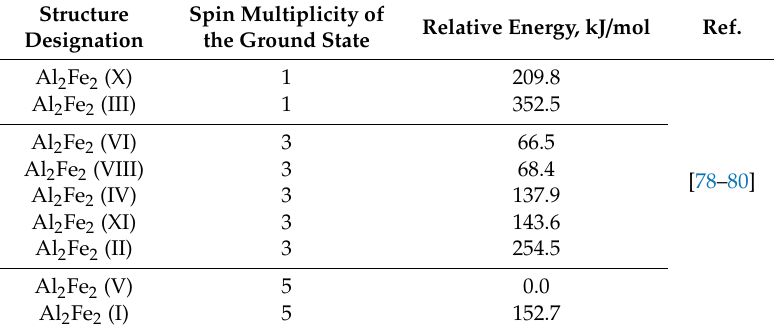
Table 2. Key structural parameters of most stable Al 3 Fe, Al 2 Fe 2 and AlFe 3 metal clusters * [76–80]. Al 3 Fe Metal Cluster